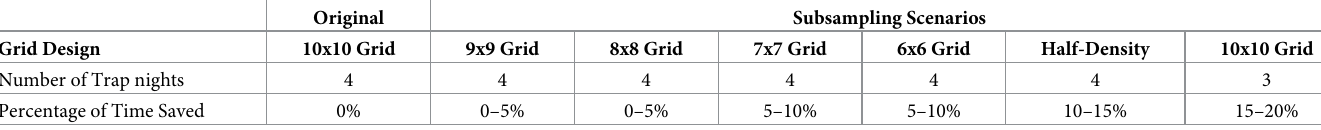
Table 3. Relative percent time saved with each subsampling scenario compared to the full grid design. Percent time estimates included pre-survey setup and logistics, time to conduct the surveys, and post-survey trap cleaning and data